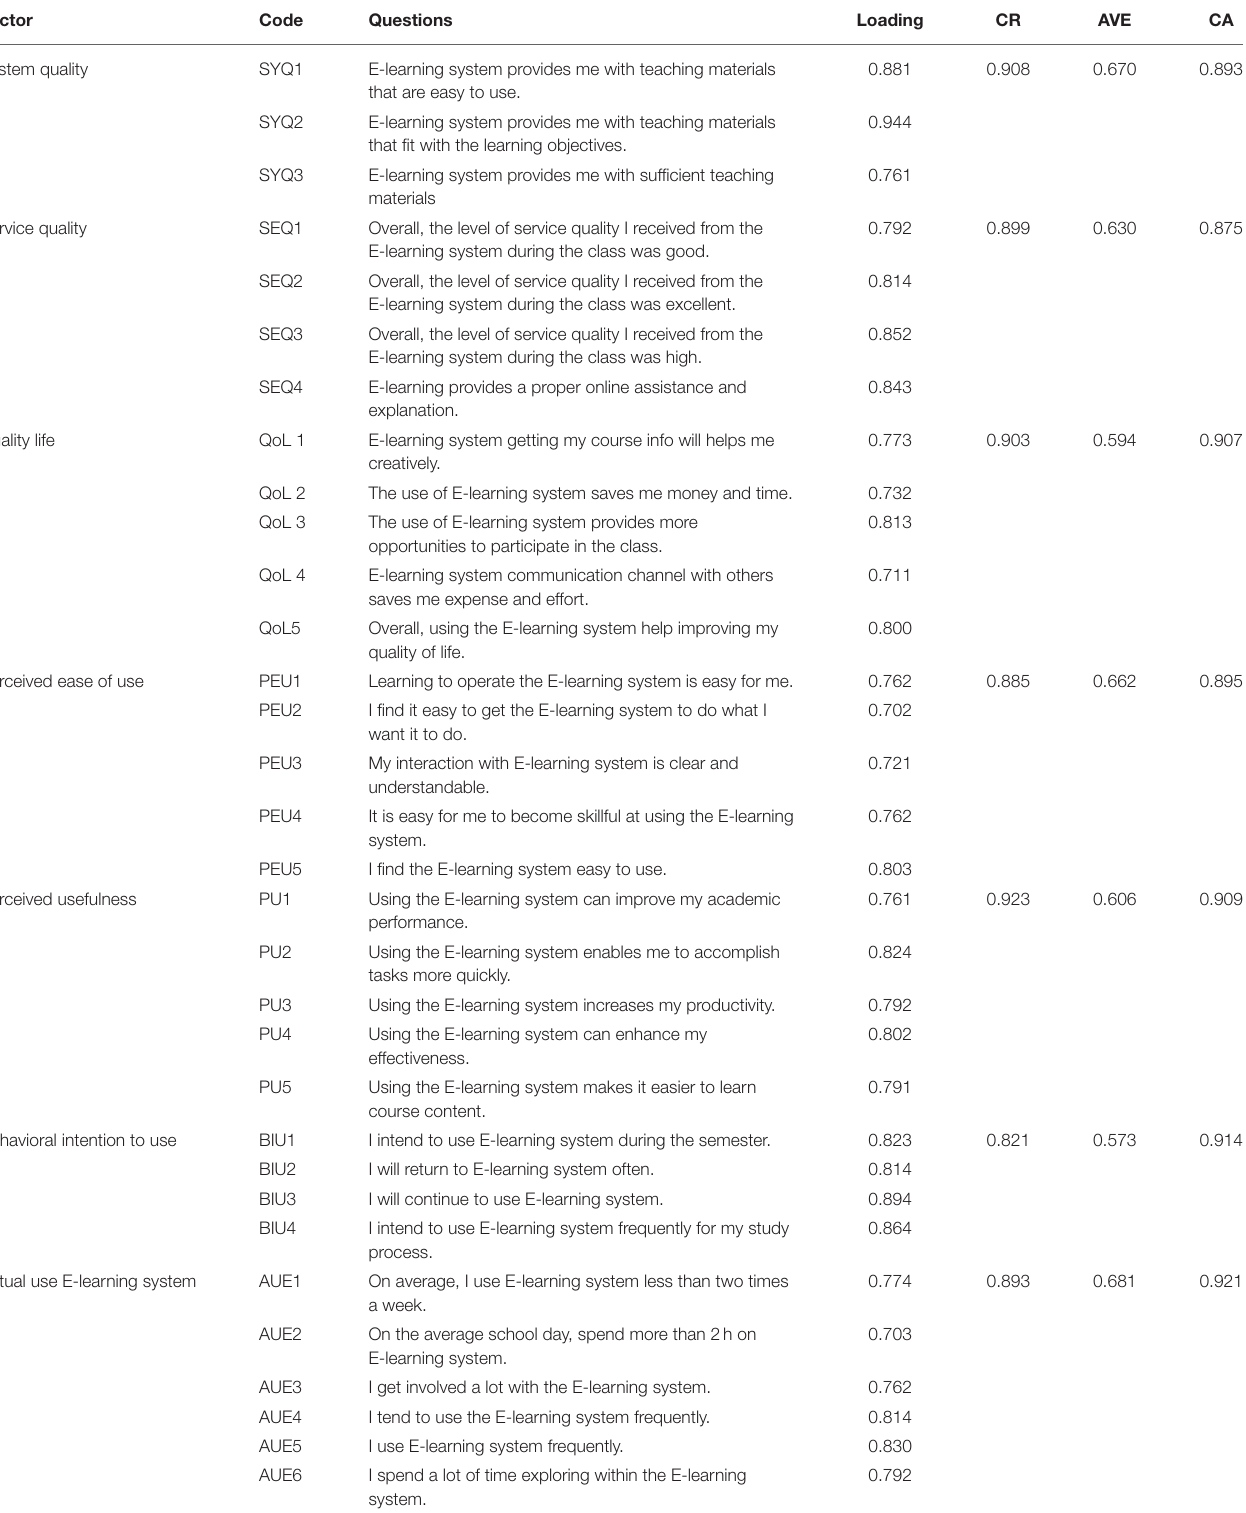
TABLE 3 | Measurement model, item loadings, build reliability, and convergent